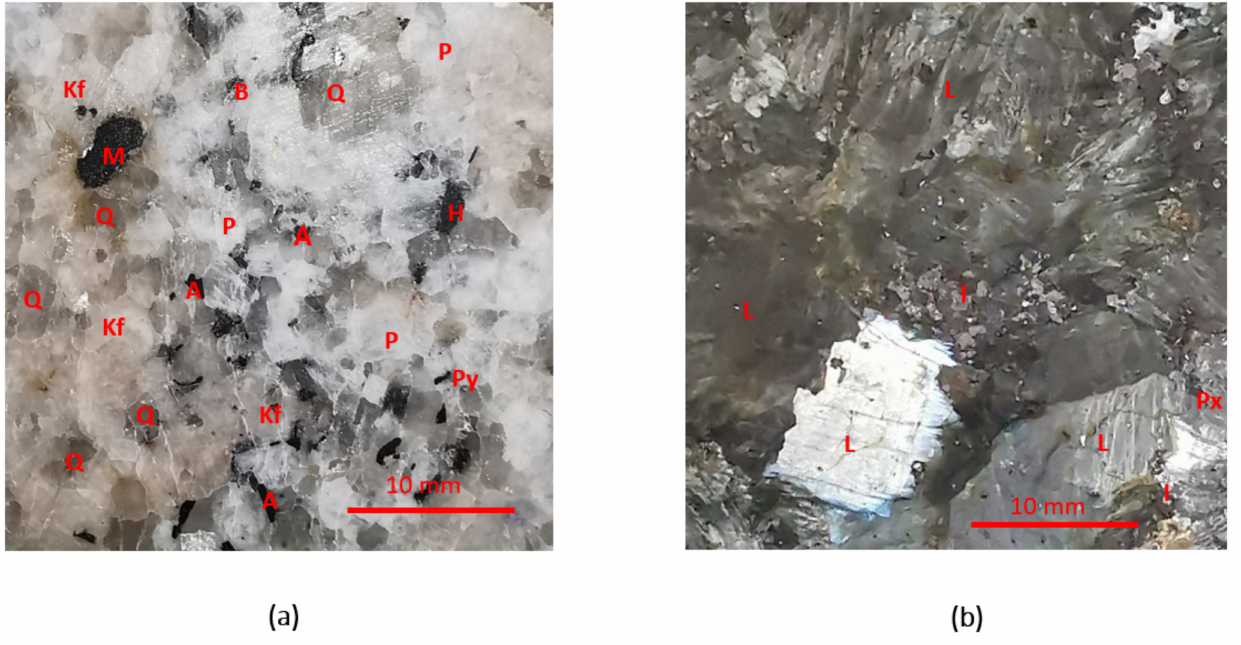
Figure 6. Microscope images of two types of rock: ( a ) gneiss (Q—quartz; Kf—potassium feldspar; P—plagioclase; B—biotite; A—aegirine-augite pyroxene; H—hornblende; M—magnetite; Py—pyrite); and ( b ) anorthosite (L—labradorite plagioclase; Px—pyroxene;